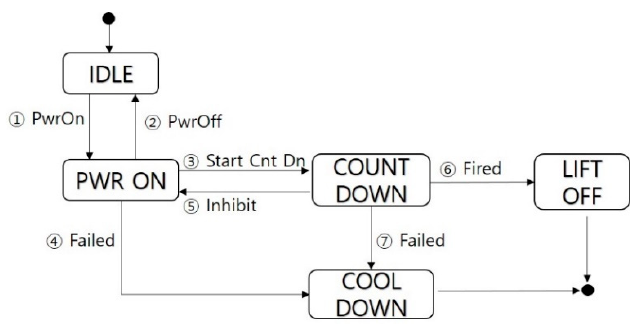
Figure 2. State machine of a sample system.